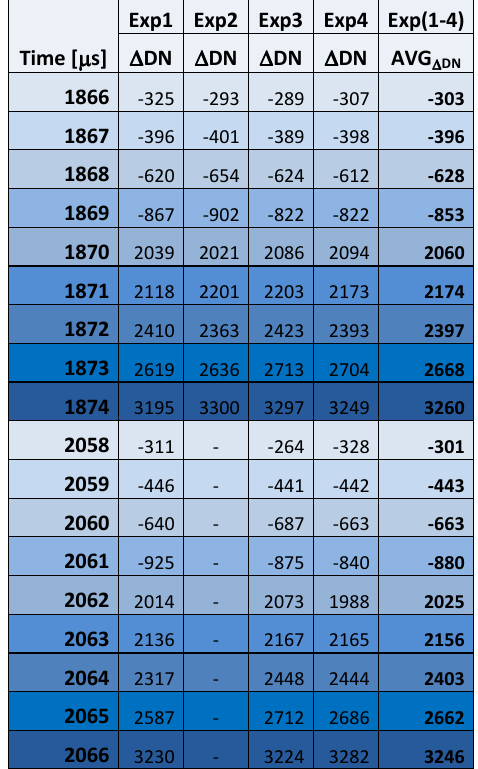
∆ DN values for two chosen integration time ranges